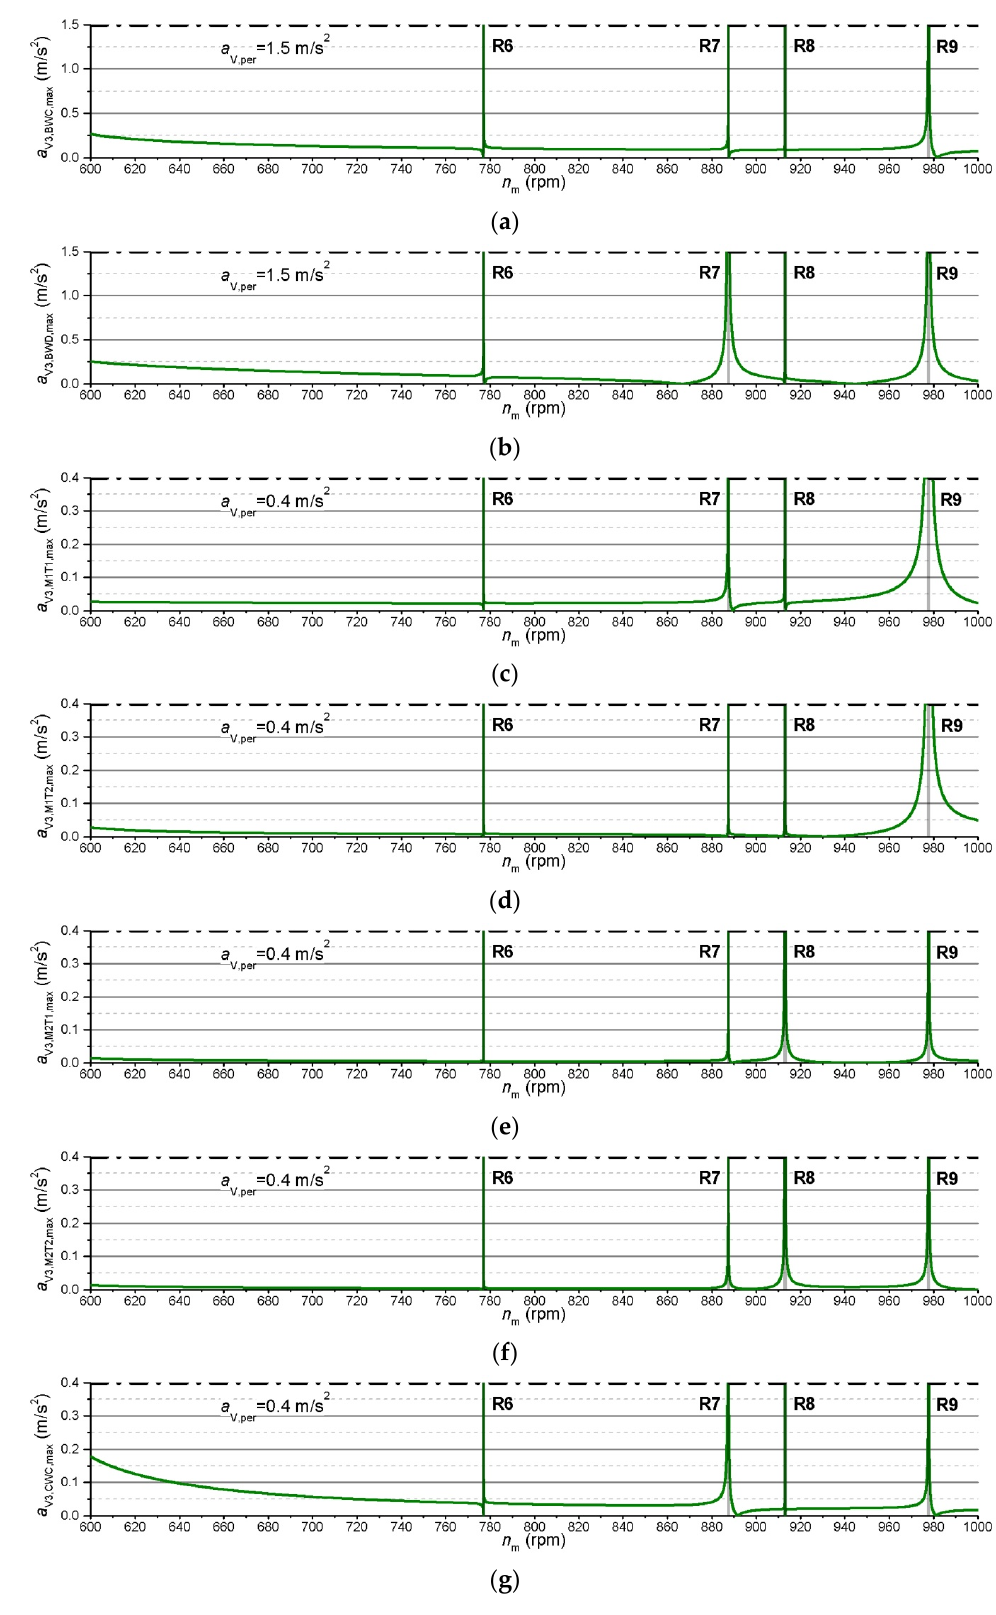
Figure 8. Response to the third harmonic of excitation—maximal vertical accelerations of the referent points of the slewing superstructure: ( a ) BWC; ( b ) BWD; ( c ) M1T1; ( d ) M1T2; ( e ) M2T1; ( f ) M2T2; ( g ) CWC.